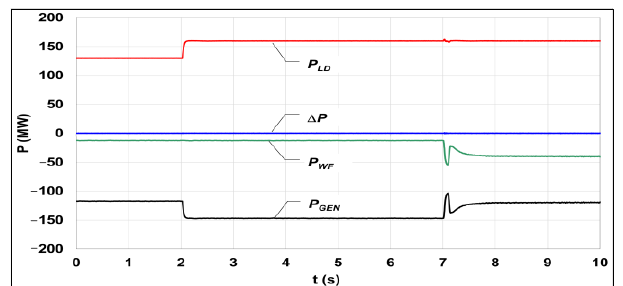
Figure 7. Changes in the active power balance in the system, resulting from the operation of the farm in the frequency regulation mode: P LD — active equivalent load power, P W F — active WF power, P GEN — active generator power, ΔP — active power losses in the network.